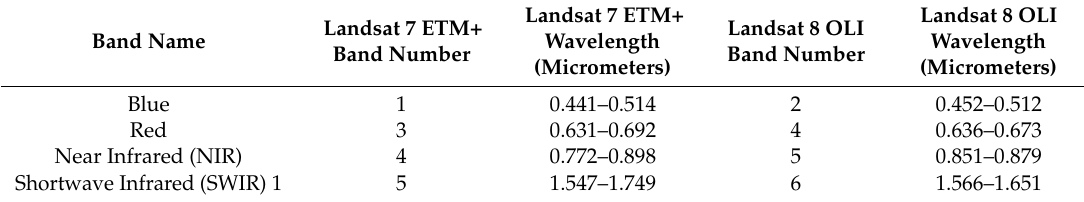
Table 2. Landsat sensors and specific bands used in VIs. All bands listed have a resolution of 30 m. This highlights the differences in wavelength of the bands between Landsat 7 and Landsat 8